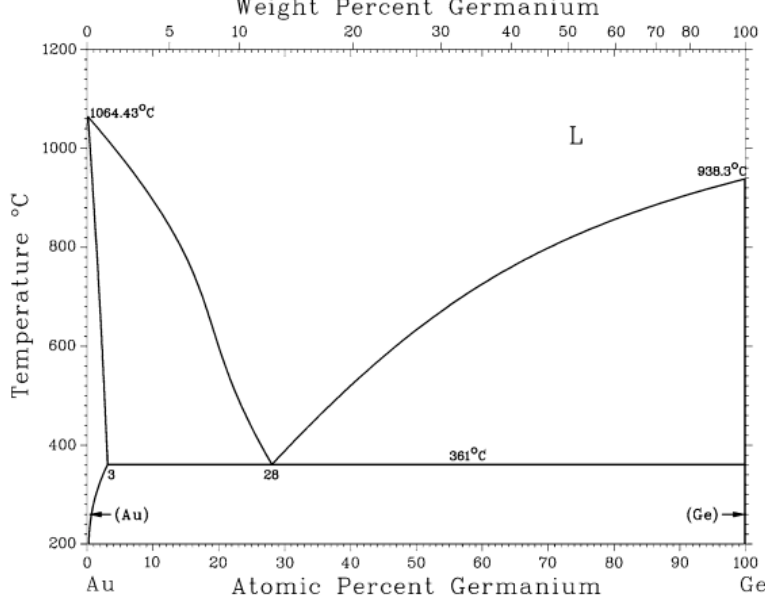
Figure 1. Phase diagram of Au-Ge alloy [25] (with permission from Spring Nature, 2020).